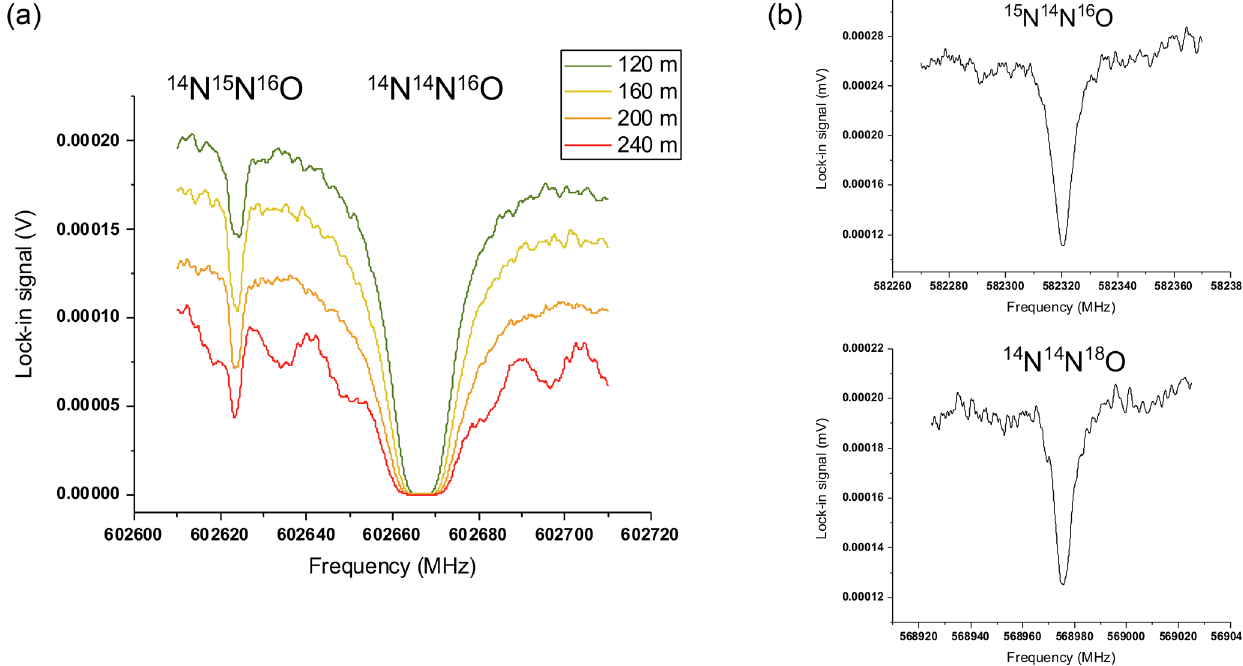
Figure 6. THz absorptions of four different N 2 O isotopomers in MULTICHARME measured without baseline treatment. (a) R( 23 ) rotational transition measured at P = 0.36mbar for the most abundant 14 N 14 N 16 O and the less abundant 14 N 15 N 16 O isotopomers; measurements are performed for four optical path lengths between 120 to 240m (in each case the 14 N 14 N 16 O absorption is saturated). (b) Measurements at P ∼ 1mbar and L = 120m, lower in frequency, of the same rotational transition for the 15 N 14 N 16 O and 14 N 14 N 18 O isotopomers. Table 1. Natural abundances of the four most abundant isotopomers of N 2 O (Gordon et al., 2022). Tabulated line intensity and frequency of the R( 23 ) rotational transition from the JPL (Pickett et al., 1998) and the HITRAN (Gordon et al., 2022) databases, respectively. Differences between tabulated and measured frequencies in Fig.